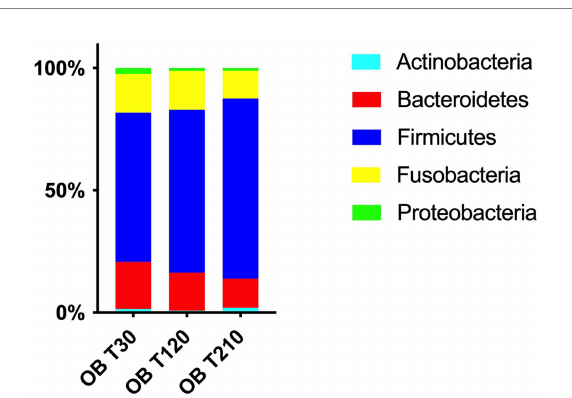
FIGURE 5 Relative abundances of the 5 most abundant phyla in fecal samples of obese dogs before (T30), after 90 days (T120) and at the end (T210) of caloric restriction; the median abundance of Actinobacteria numerically decrease at T120 compared with T30 ( q > 0.05) and then significantly increased at T210 compared with T120 (1.9% vs. 0.7%, q = 0.014). Moreover, a tendency to a decrease was observed between T30 vs. T120 and T120 vs. T210 for Bacteroidetes (T30: 19% vs. T120: 14% and T120: 14% vs. T210: 13%, q = 0.051) and between T30 vs. T120 for Proteobacteria (T30: 2.4% vs. T120: 1.1%, q =